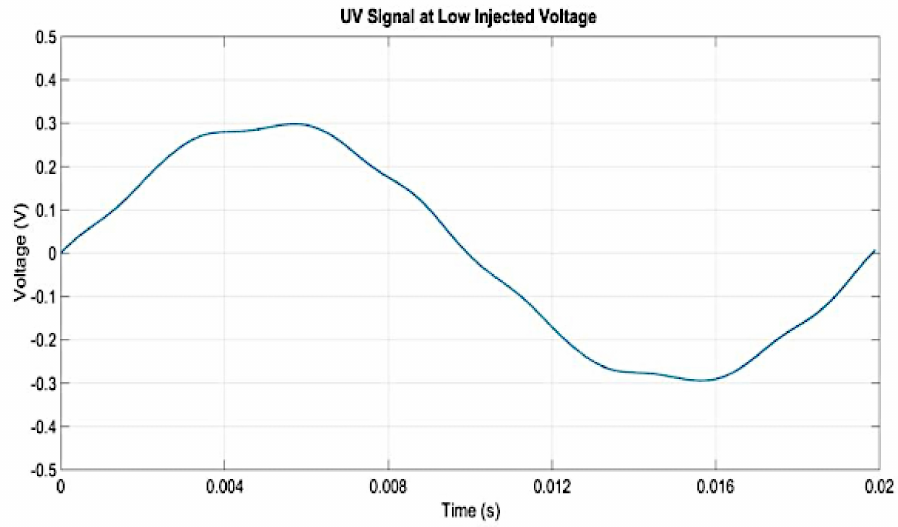
Figure 6. Signals detected at low injected